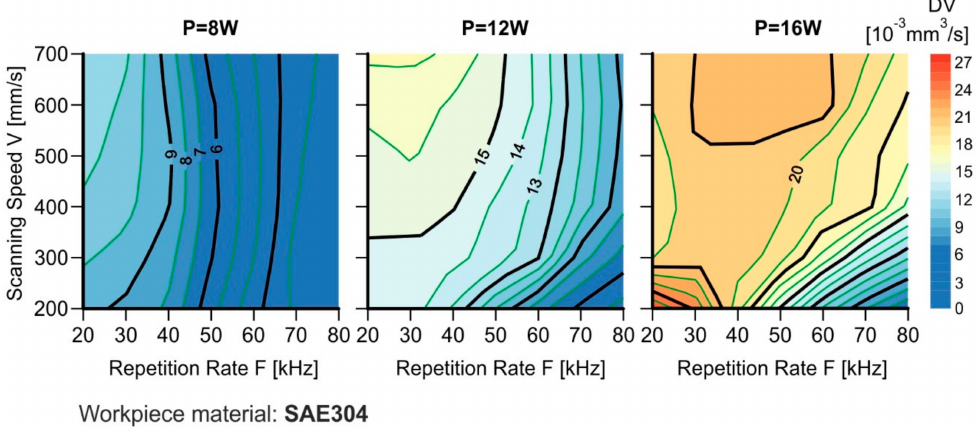
Figure 6. Material removal rate DV